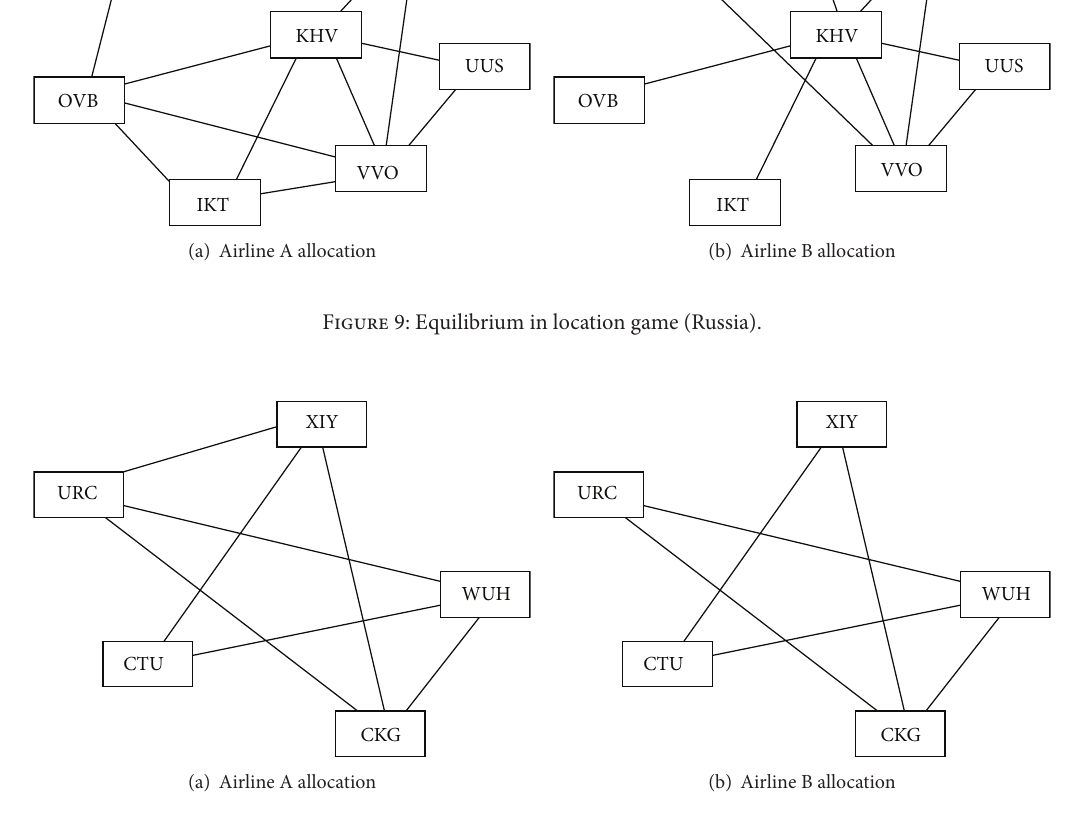
Figure 10: Equilibrium in location game (China).